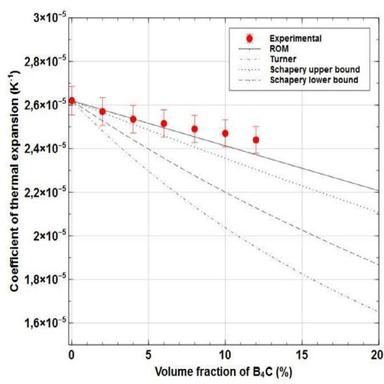
CTE of Al/B4C composites between 50 °C and 250 °C with different B4C contents.